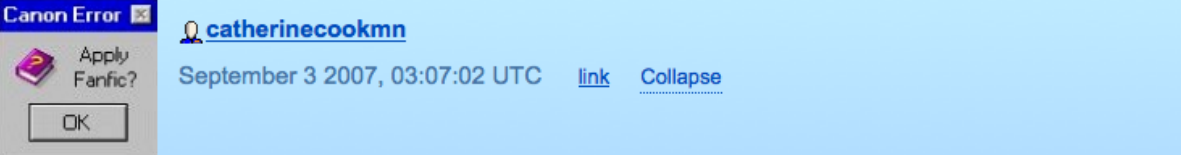
Figure 2. Screenshot of The Severus Snape Rescue Squad promotion